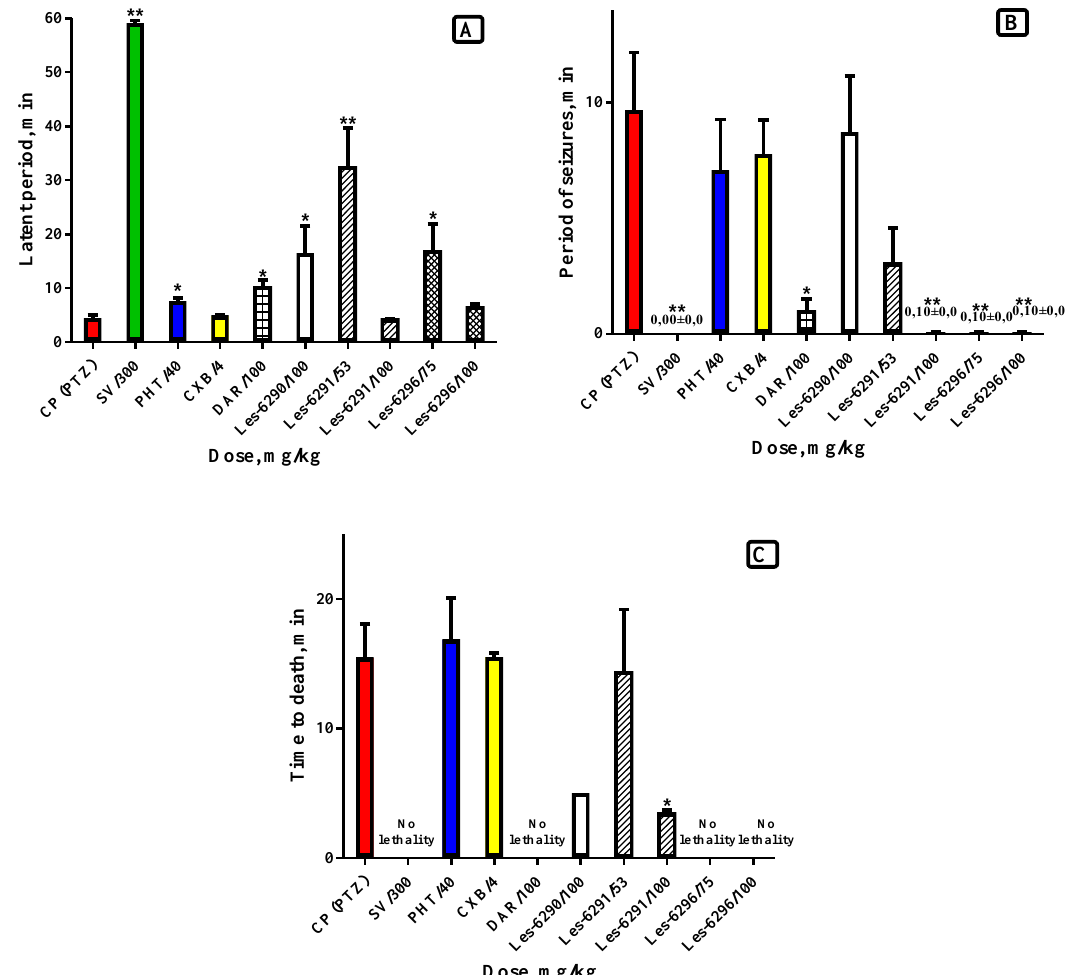
Figure 3. Anticonvulsant activity of the reference drugs, celecoxib, dual COX-2/5-LOX inhibitor darbufelone methanesulfonate and derivatives Les-6290, Les-6291, and Les-6296 in the scPTZ test: ( A ) latency to the first seizure episode; ( B ) duration (period) of seizures; ( C ) time to death. Each value represents the mean ± S.E.M. obtained from 6 mice. CP(PTZ), control pathology; SV, sodium valproate; PHT, phenytoin; CXB, celecoxib; DAR, darbufelone methanesulfonate; * p < 0.05; ** p < 0.01 compared to the group control pathology (CP (PTZ)).